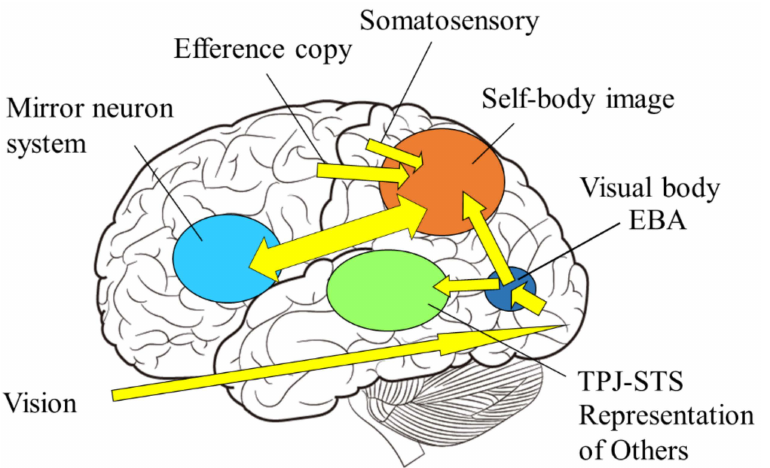
Figure 9. Self-body recognition and the mirror neuron system. Extrinsic (vision, sound) and in- trinsic (proprioceptive, somatosensory, and motor) body information are integrated in the parietal lobe. If those are consistent, the self-body image emerges in the superior parietal and intraparietal regions, and possibly extends to the premotor cortex, consisting of mirror neuron system, otherwise representations of others emerge in the TPJ and/or STS